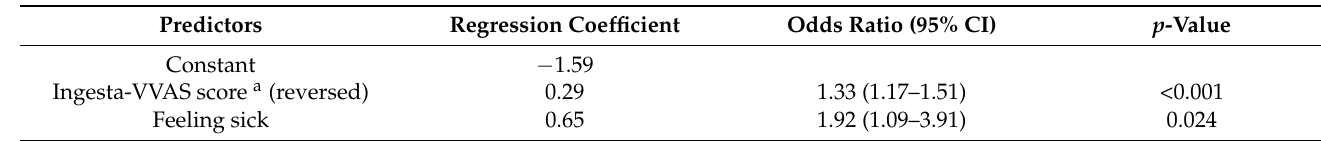
Table 4. Final multivariate model for prediction of energy intake <75% of Total Energy Expenditure (TEE) ( n =